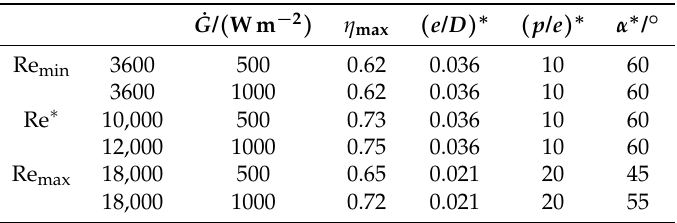
Table 10. Maximum efficiency and optimum roughness parameters according to the model developed by Sethi et al. [47].